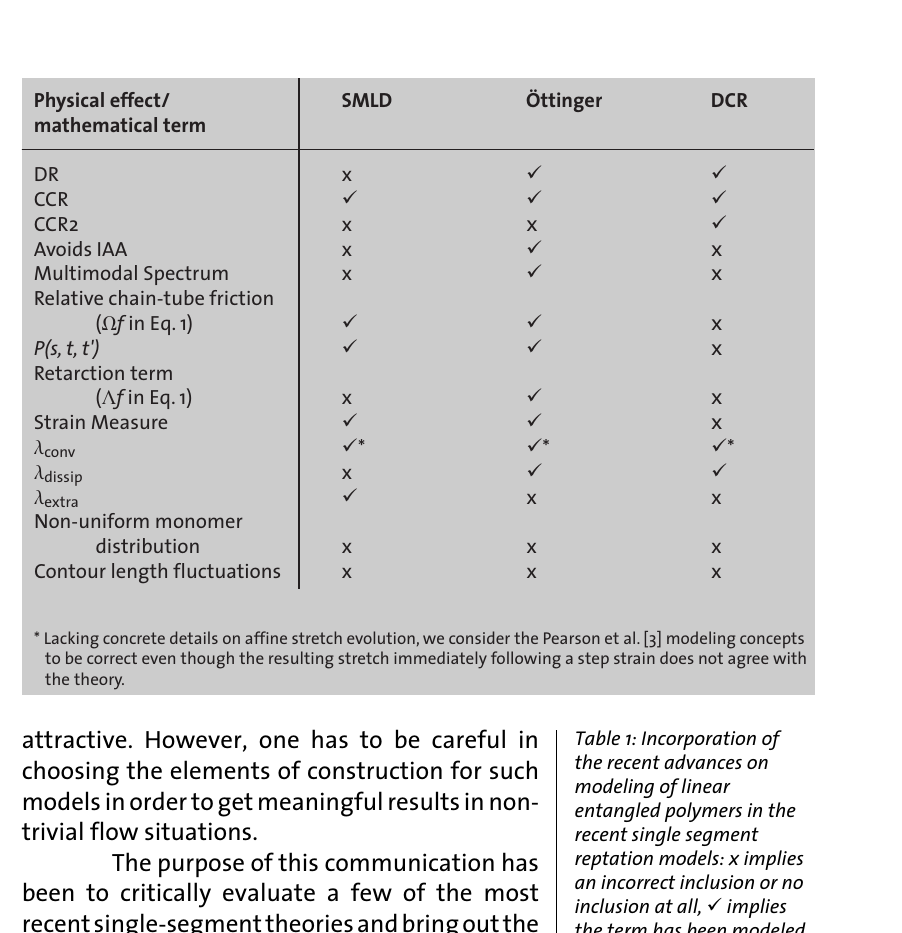
Table 1: Incorporation of the recent advances on modeling of linear entangled polymers in